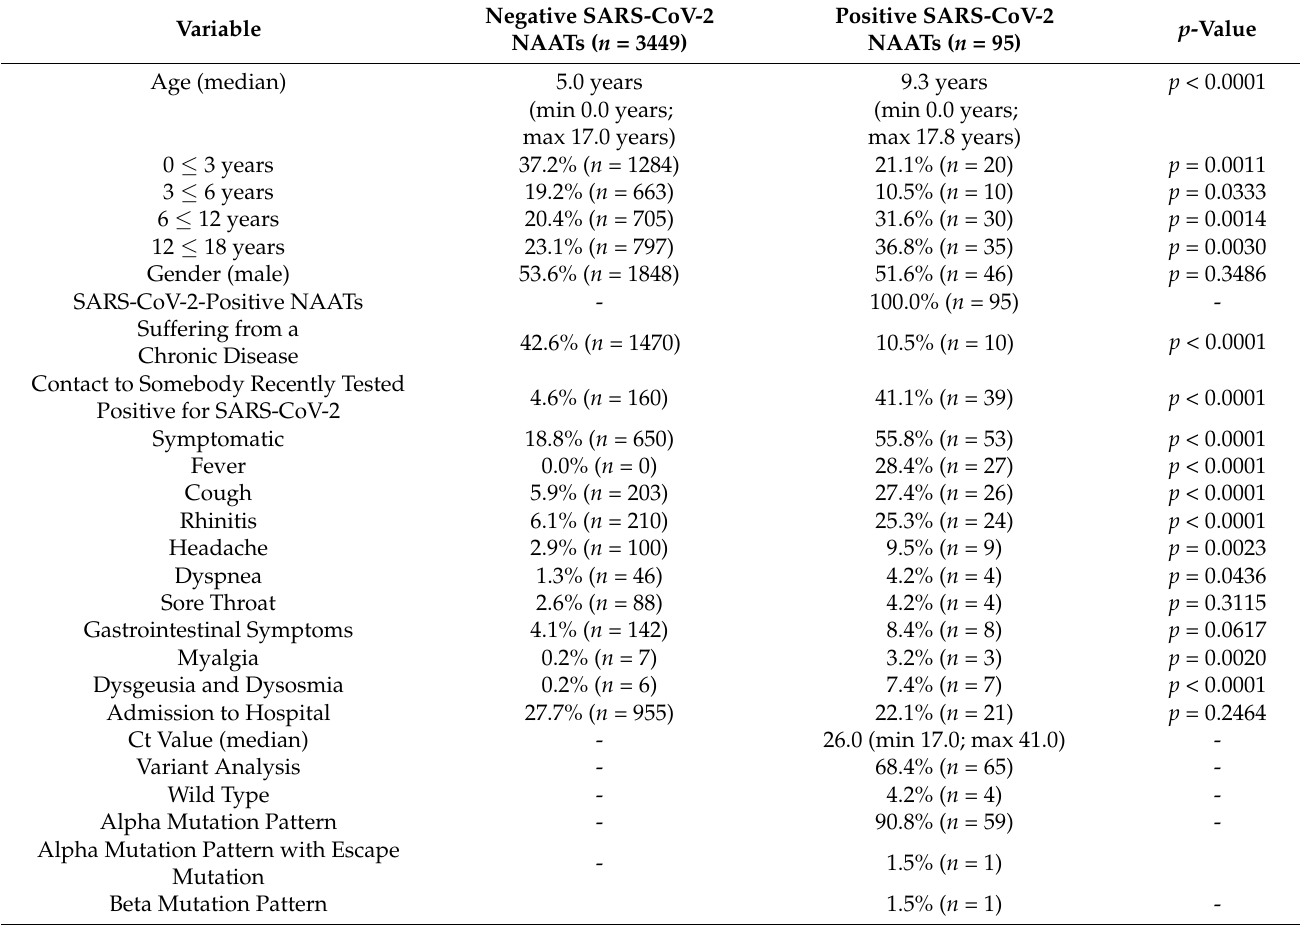
Table 2. Patients tested negative for SARS-CoV-2 vs. patients tested positive (Alpha mutation pattern: N501Y, Del69/70: negative for E484K; Alpha mutation pattern with escape mutation: N501Y, Del69/70: positive for E484K; Beta mutation pattern: N501Y, E484K, and K417N; negative for